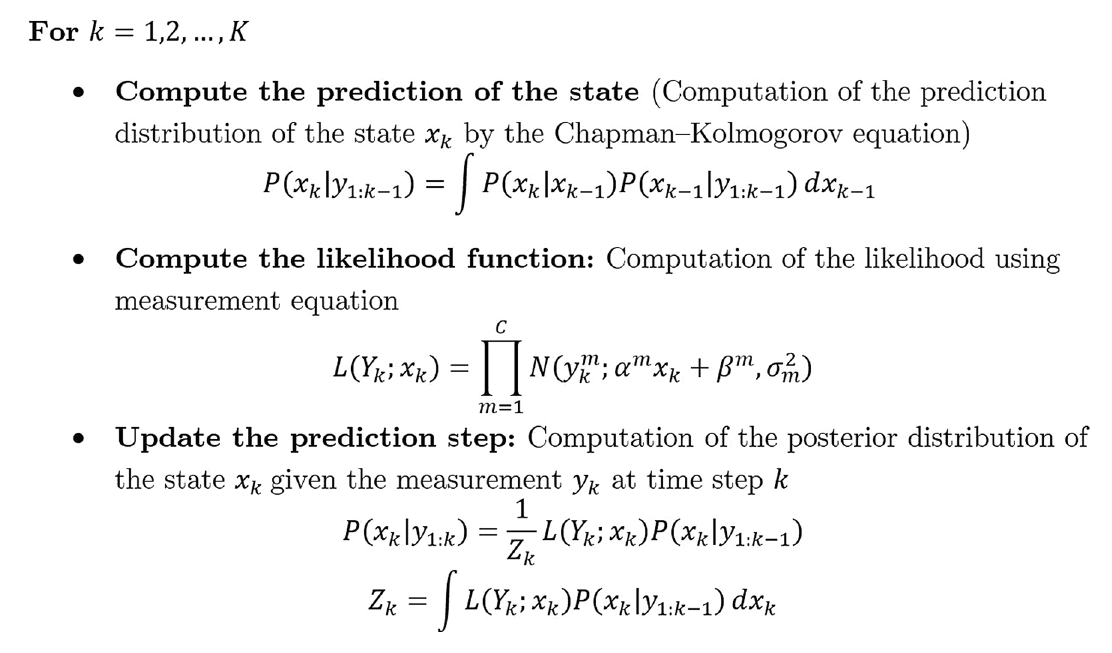
Figure 5. PERCLOS Decoder Model. These three steps are called recursively over time as new neural features are becoming